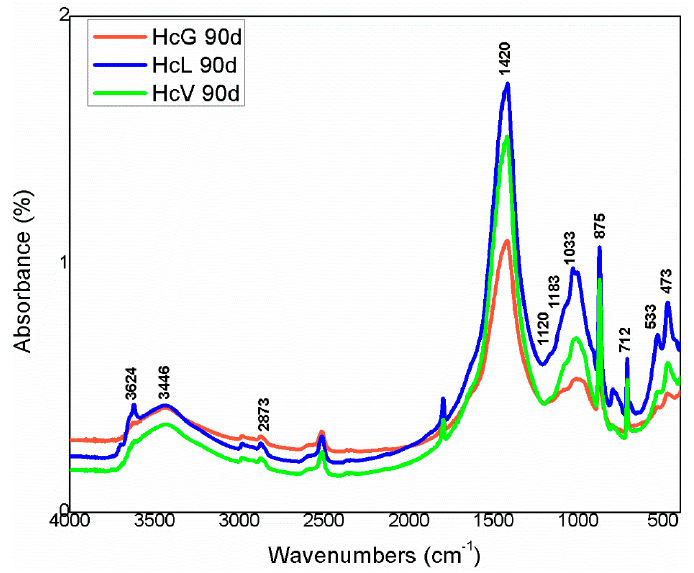
Figure 18. FTIR spectra for 90 days Hc waste.